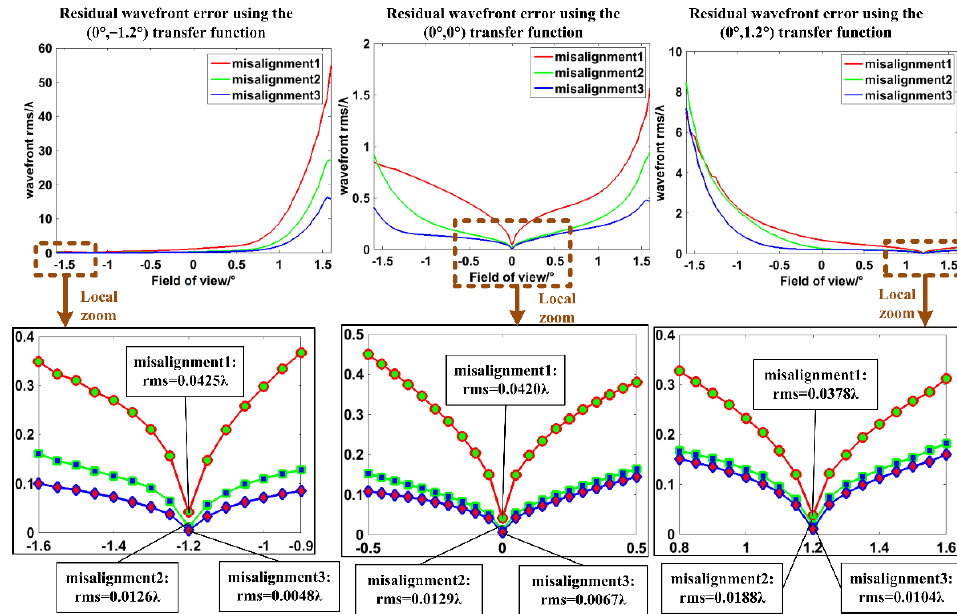
Figure 2. The residual wavefront errors after aberration correction using different transfer functions.